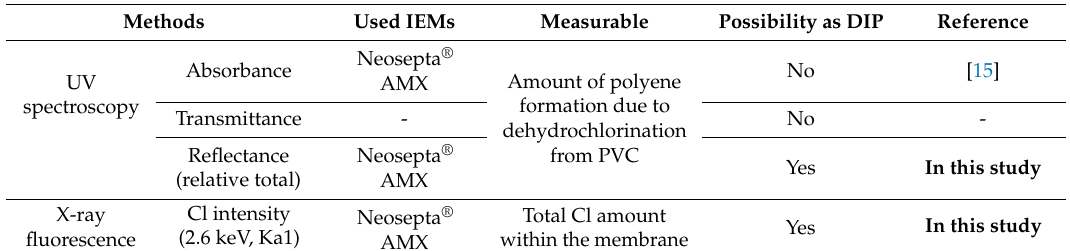
Figure 7. A relationship between normalized relative total VIS reflectance and normalized Cl intensity for all immersion conditions. Table 1. Comparison of the analyses for alkali-attacked ion exchange membranes (IEMs) to predict the resulting performance. DIP: diagnosis-in-place; PVC: polyvinyl chloride.